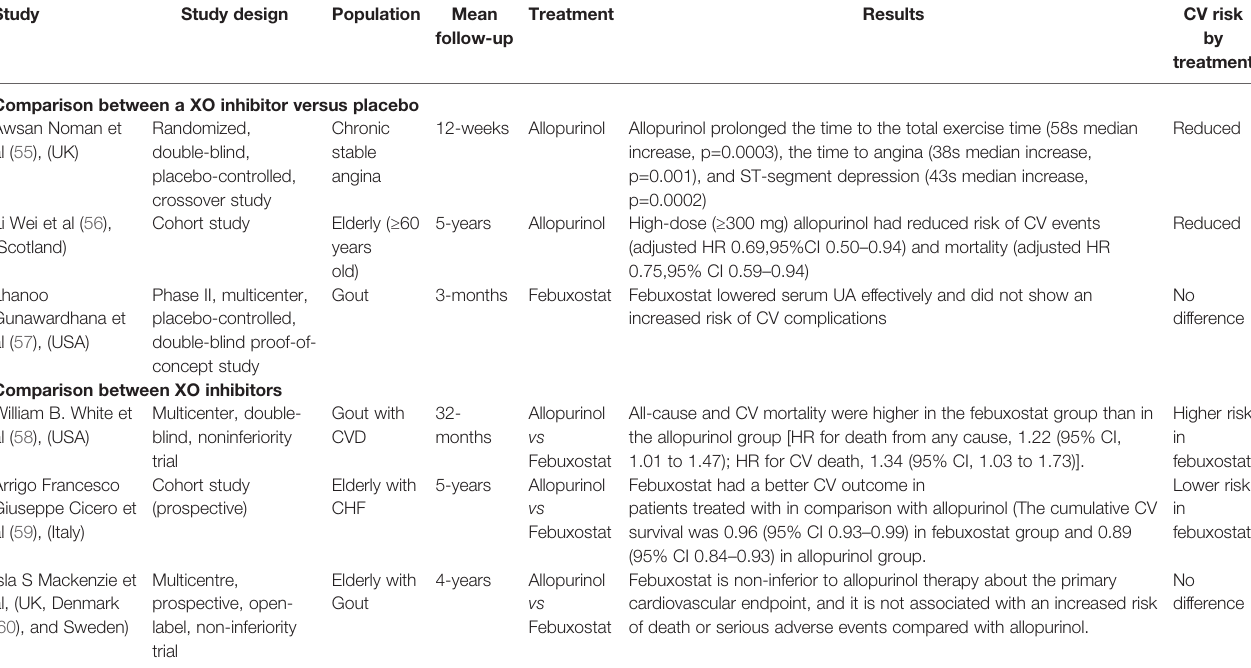
TABLE 1 | Studies to assess or compare the effect of XO inhibitors in